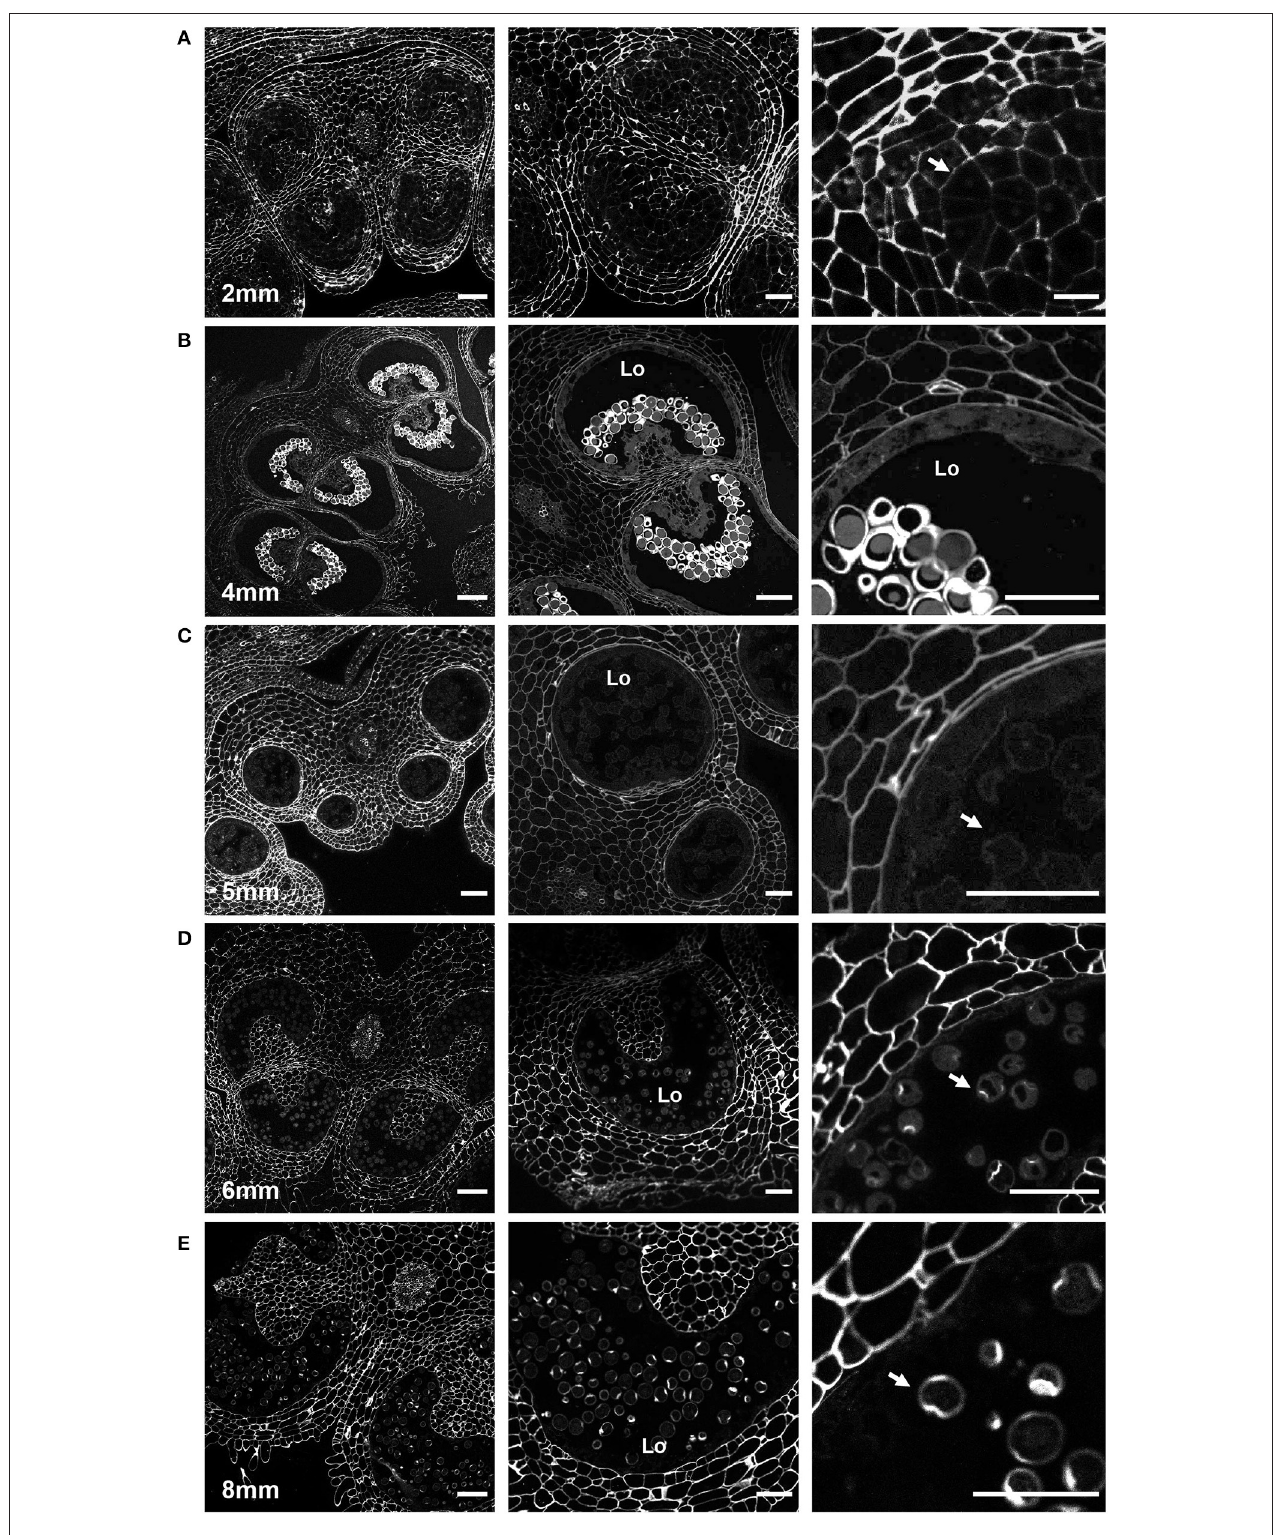
FIGURE 4 | Calcofluor white staining of pollen development. Fluorescent micrographs of anther cross sections (500nm) in LR white, stained with calcofluor white. (A) The microspore mother cell stage in the 2-mm bud anther. (B) The tetrad stage in the 4-mm bud anther. (C) The uninucleate microspore stage in the 5-mm bud anther. The arrow marks the microspore wall. (D) Bicellular pollen in 6-mm bud anther. The arrow marks the pollen wall. (E) Mature pollen in 8-mm bud anther. The